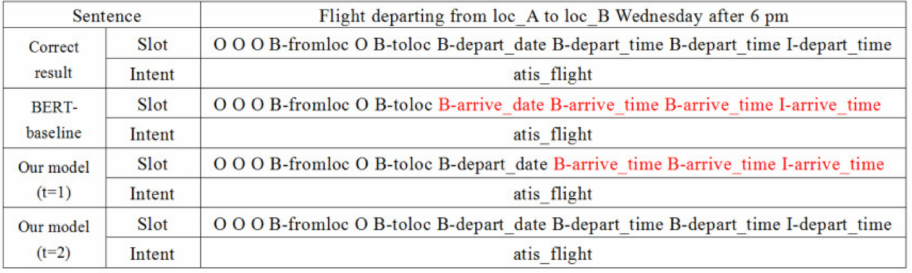
Figure 4. In an example sentence with OOV words, red content indicates an incorrect